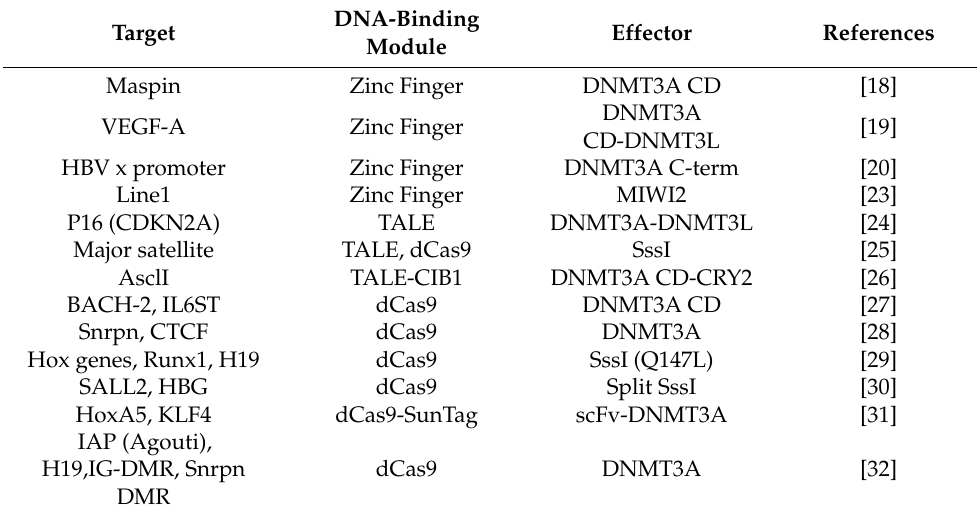
Table 1. Editing DNA methylation with